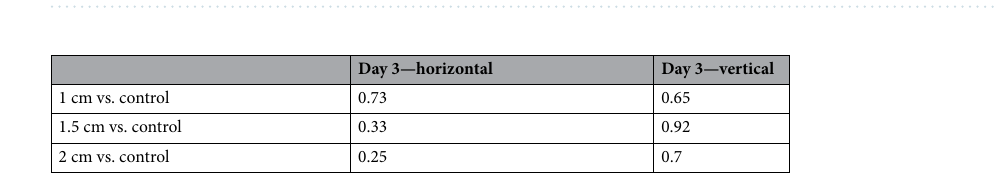
Figure 3. Illustration of inhibition measurement at the core. ( a ) Illustration of inner core segmentation with mirroring and fitting to ellipse. ( b ) Colony core deformation analysis. At each distance from CHX source (control and 1/1.5/2 cm) the ratio between horizontal (left) and vertical (right) radii between the unexposed and exposed halves is shown.